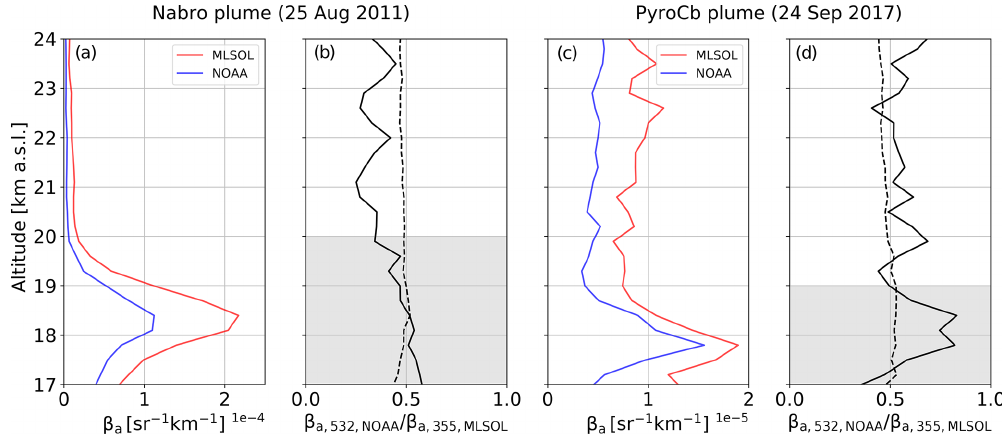
Figure 9. Backscatter derived from MLSOL (red) and NOAA lidar (blue) and corresponding color ratios for the Nabro plume (a, b) and the British Columbia (pyroCb) smoke plume (c, d) . In the color ratio plots, the corresponding average color ratio derived for the volcanic active and second quiescent period (see Fig. 8b) is included for reference (dashed black). The altitude interval affected by these two features is highlighted in grey.